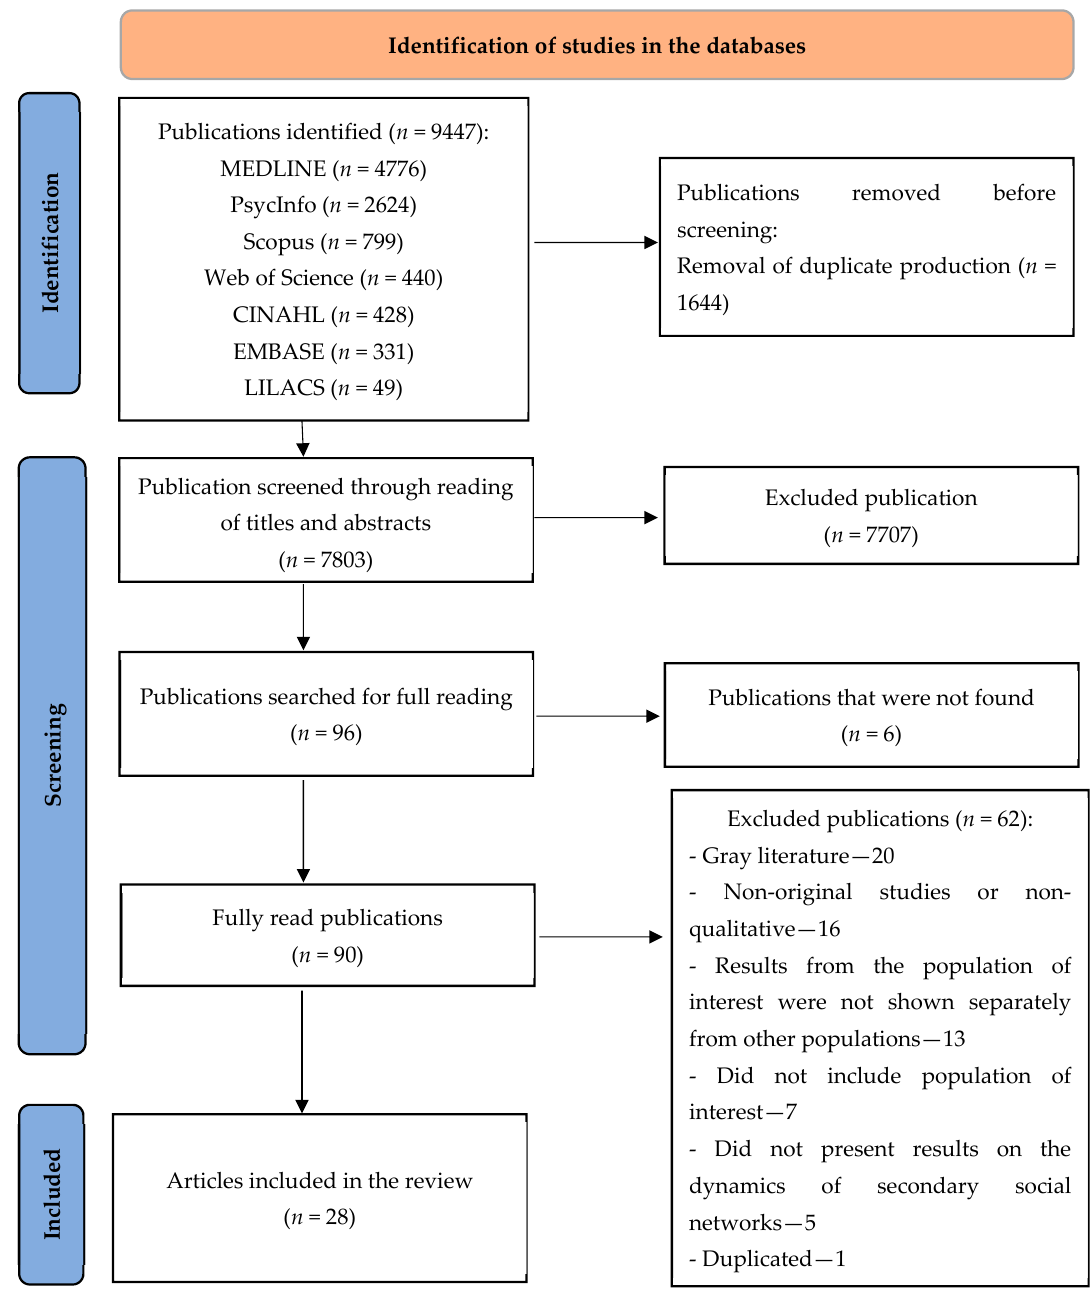
Figure 1. Flowchart of studies selected for systematic review on the dynamics of secondary social networks to support mothers, fathers, or guardians of transgender children and adolescents. Ribeirão Preto, SP, Brazil, 2022. Source: Adapted from Page et al. [10].